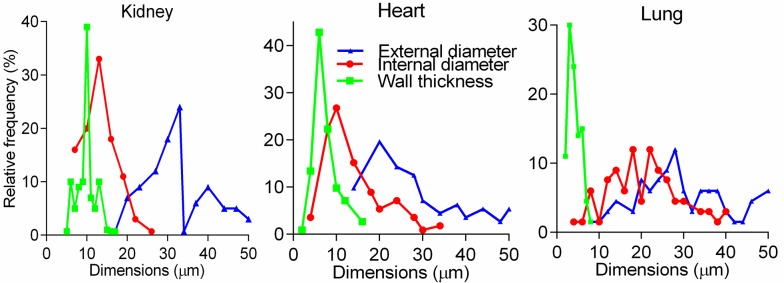
Detailed statistical analysis of primary data.Histograms for the external diameter, internal diameter, and wall thickness in the kidney, heart and pulmonary arteries, used to calculate statistics in Table 1, demonstrated irregular frequencies and profound asymmetry.